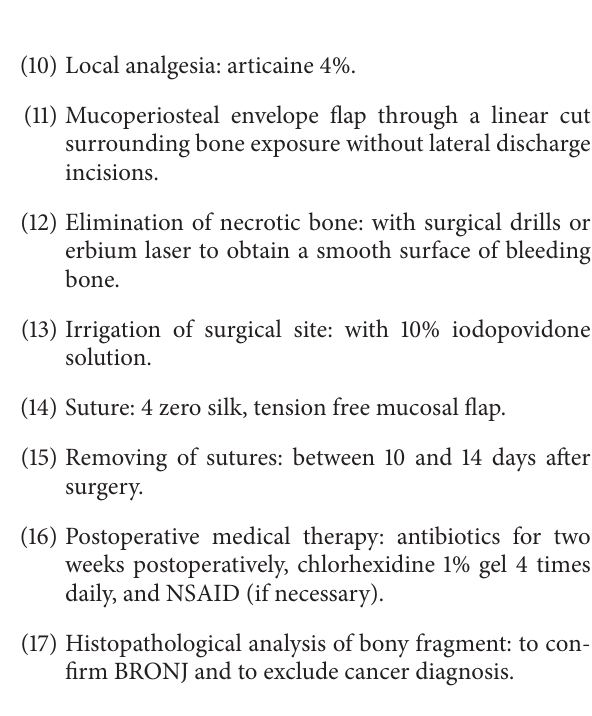
BPT duration (months ±